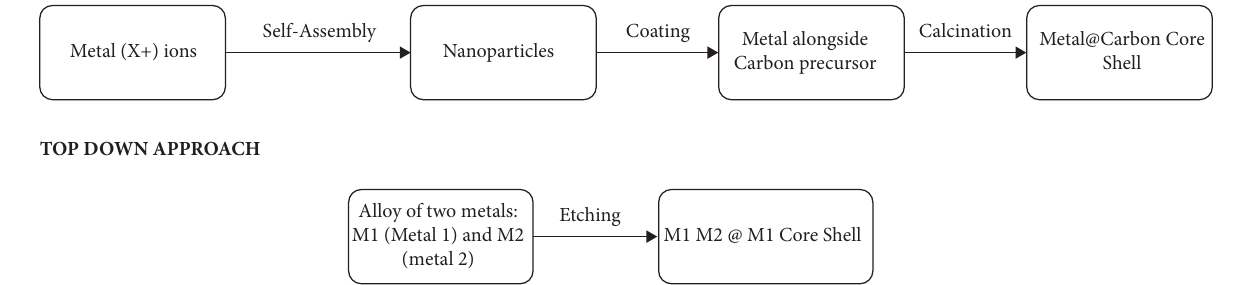
Figure 14: Two different approaches for designing renewable substrates.